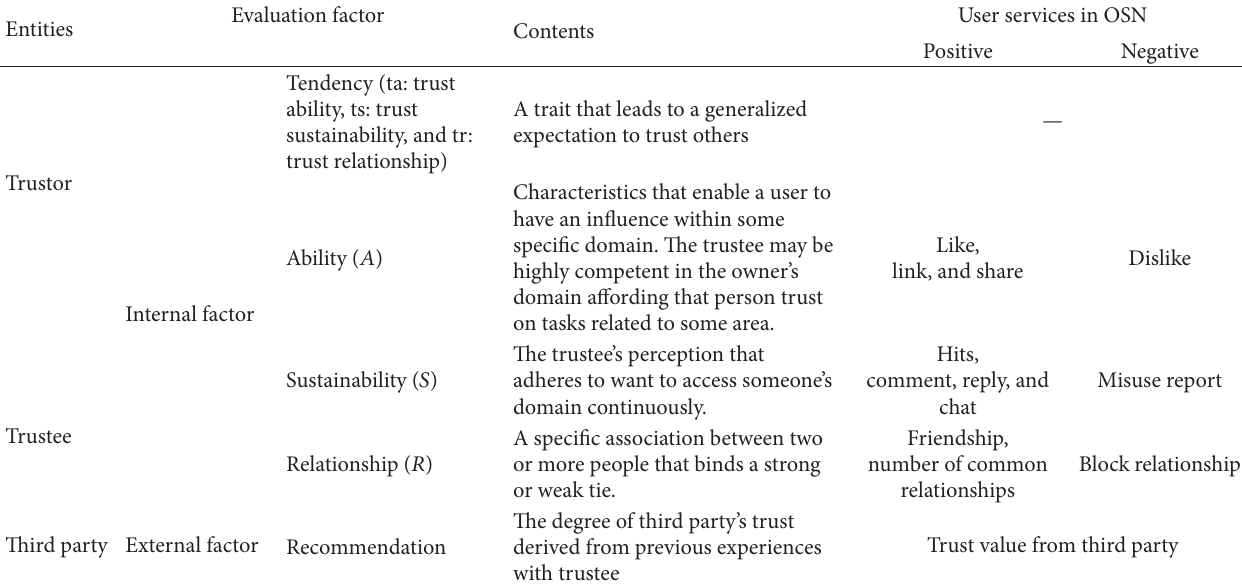
Table 3: Proposed trust evaluation factors and OSN